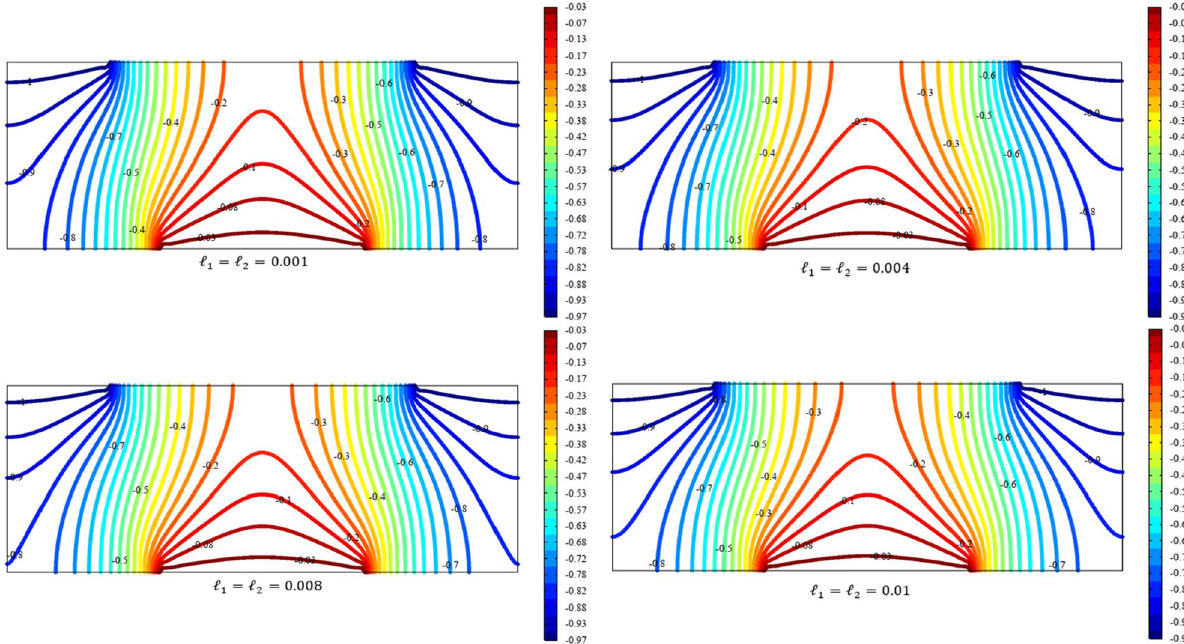
/ | u 0 | for different values of ℓ 1 and ℓ 2 (COMSOL (cid:30)